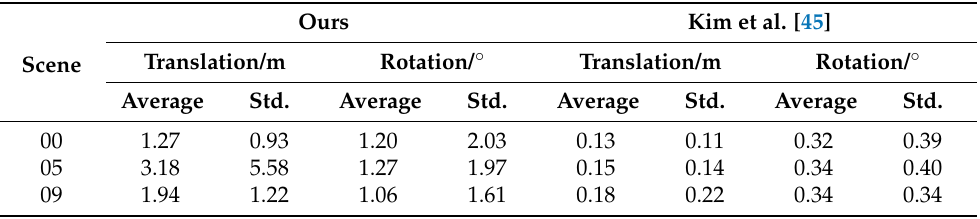
Table 1. Comparison of average localization errors and standard deviation between the proposed method and the method in